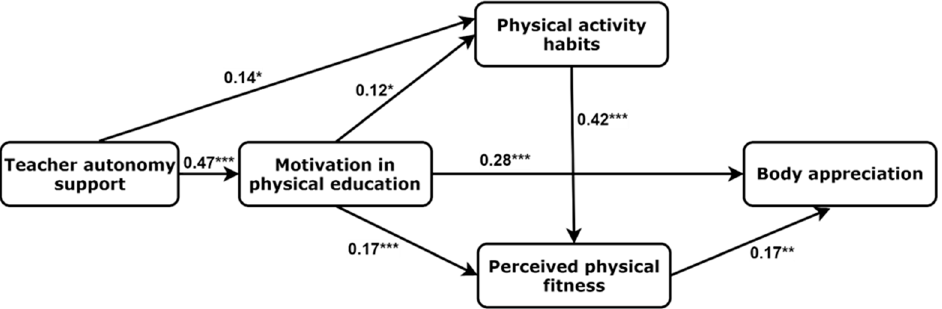
Figure 2. Hypothetical model of the associations between study measures. * p < 0.05; ** p < 0.01; *** p < 0.001.